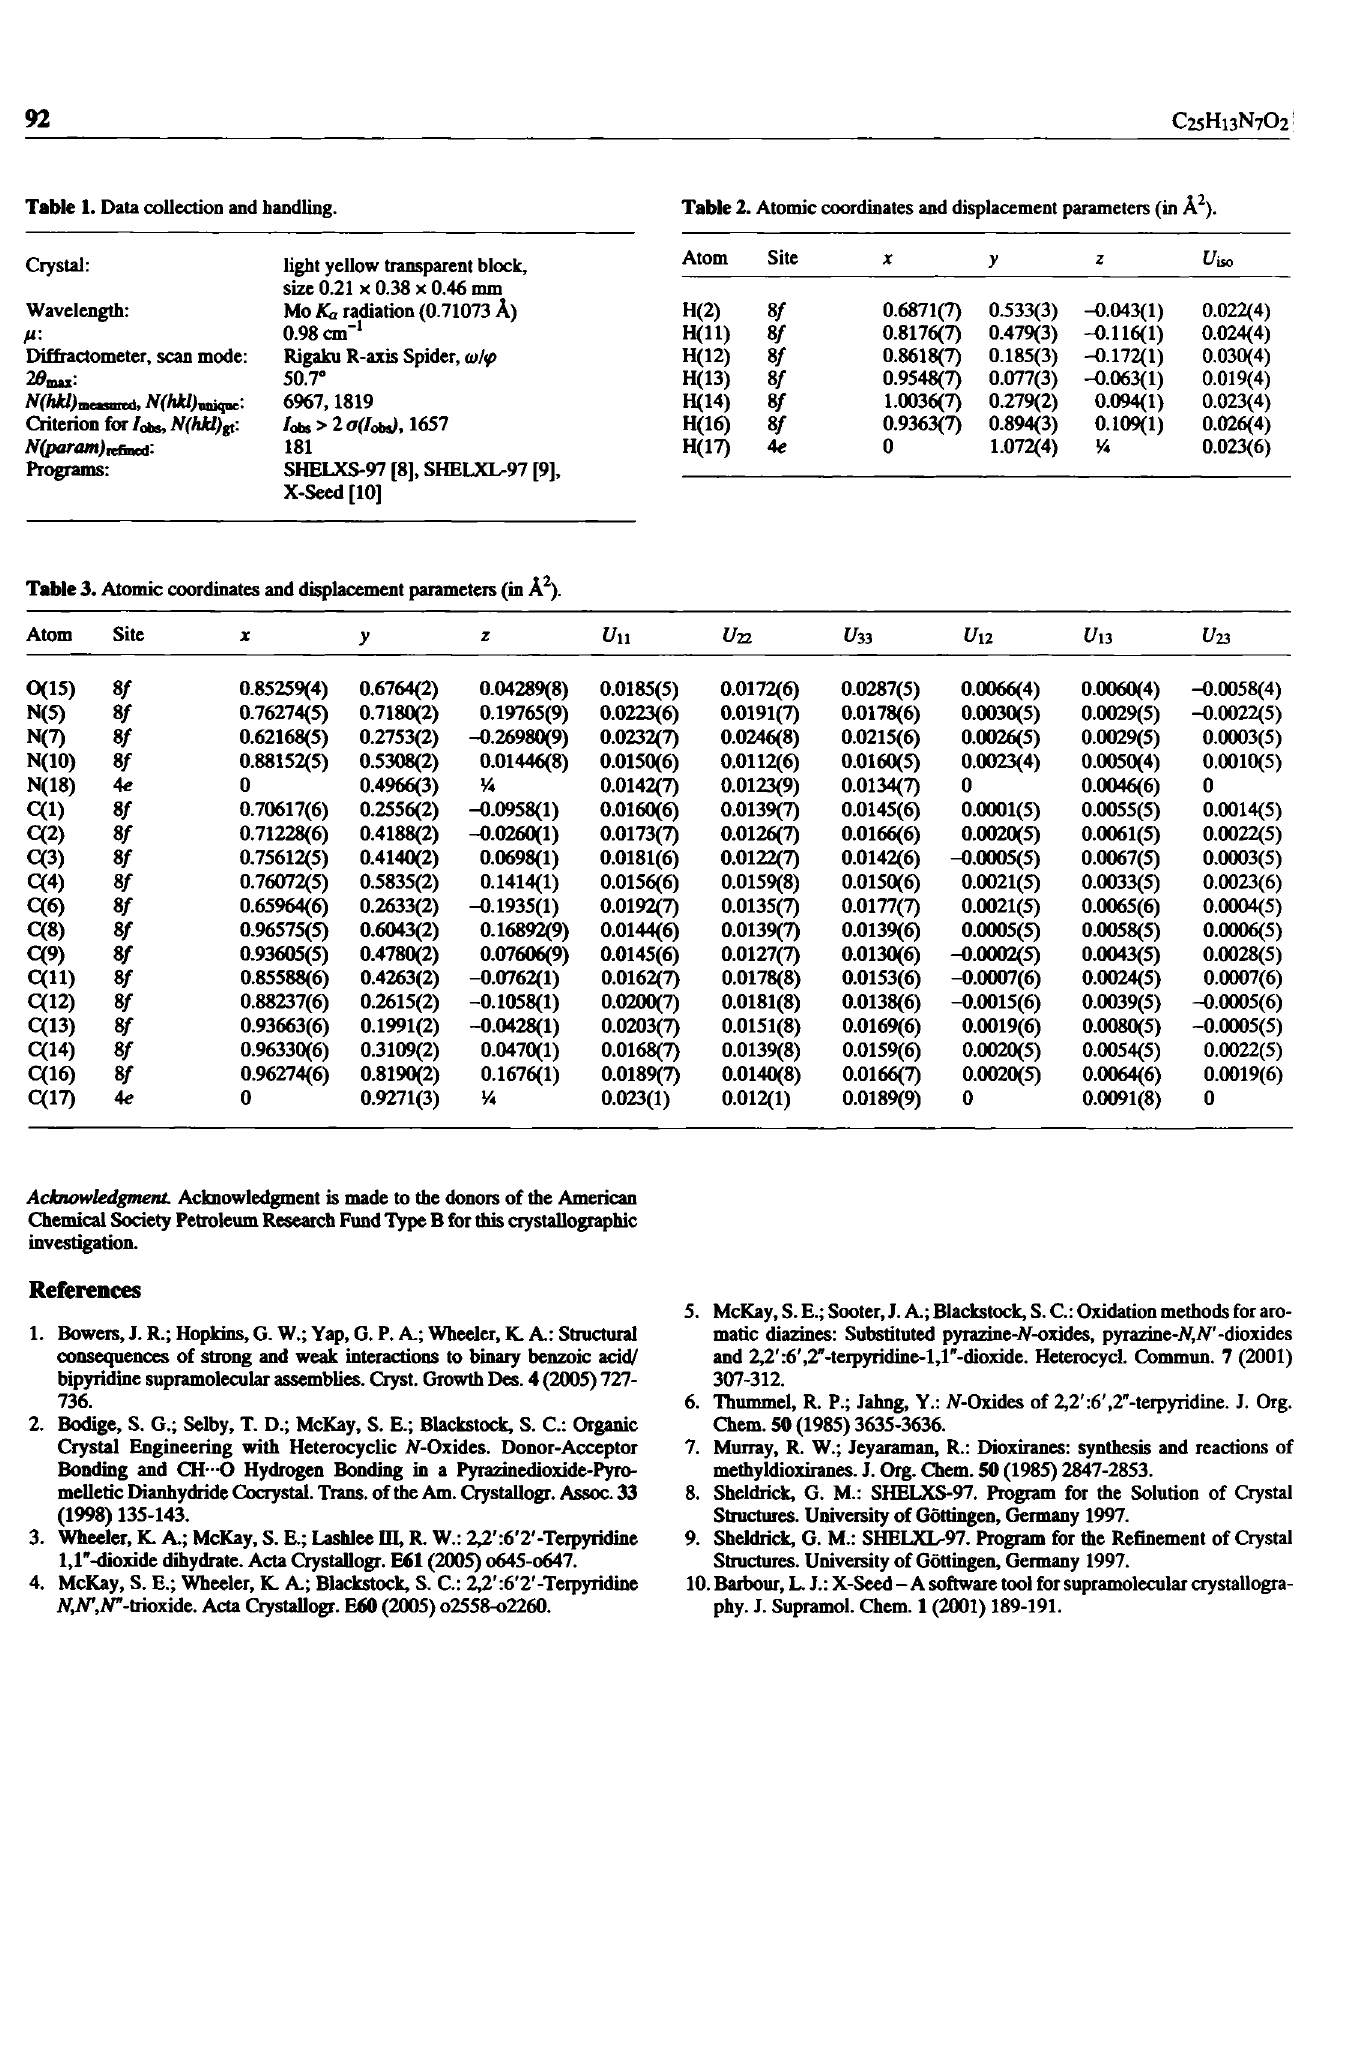
Table 3. Atomic coordinates and displacement parameters (in A 2